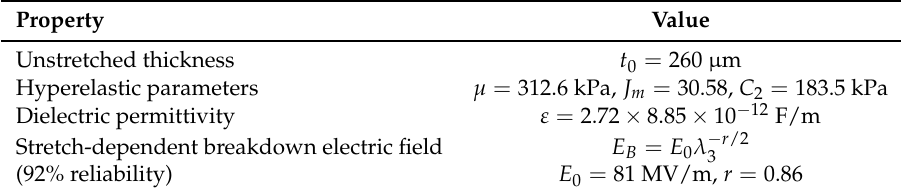
Table 1. Theraband Yellow 11726’s electro-mechanical properties